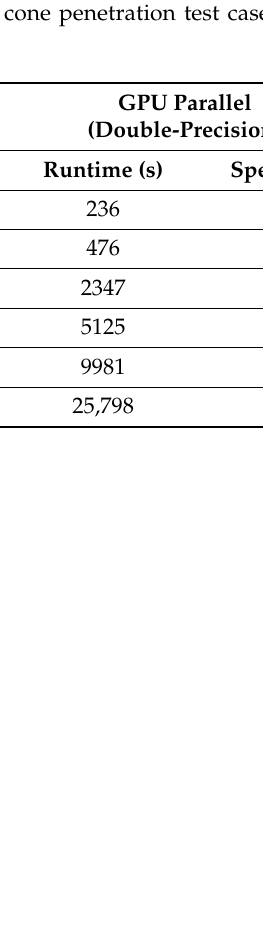
Figure 12. Speedups of GPU parallelisation for cone penetration test.